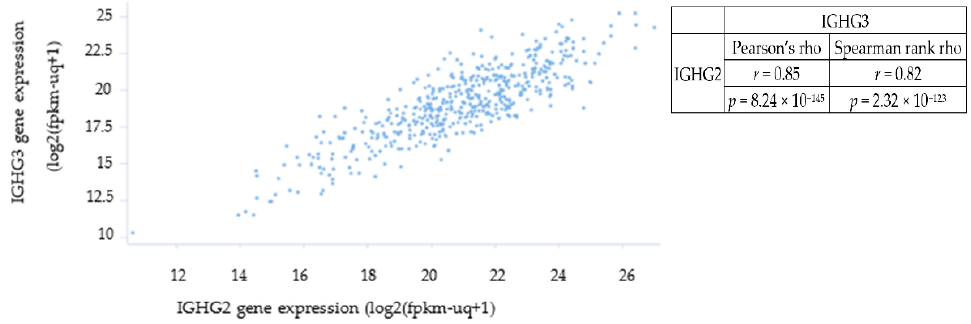
Figure 1. IGHG2 and IGHG3 expression levels were examined in 571 CRC patient samples following